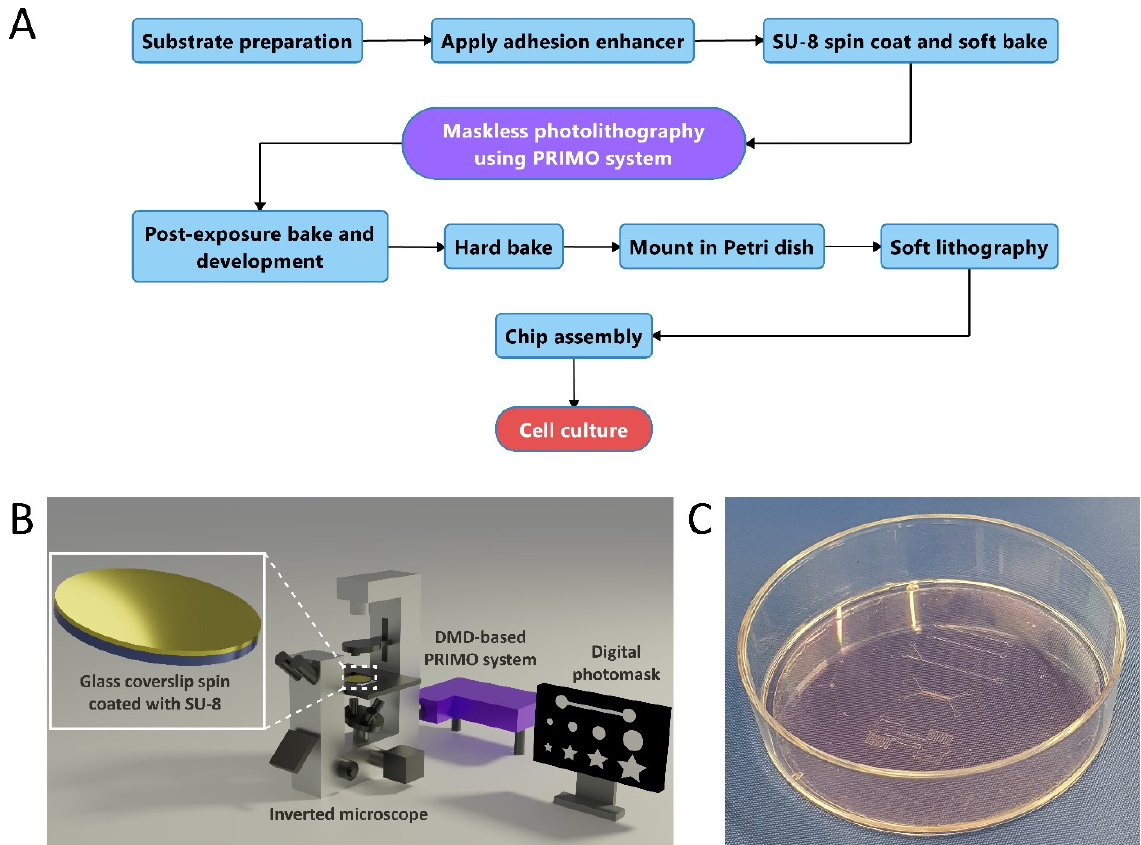
Figure 1. Microfabrication process flow using maskless photolithography. ( A ) Flowchart showing the developed approach to rapidly fabricate OoC devices. ( B ) Schematic of DMD-based maskless photolithography setup (PRIMO). ( C ) Photograph of microfabricated SU-8 mold mounted into a Petri dish (60 mm diameter) for soft lithography.